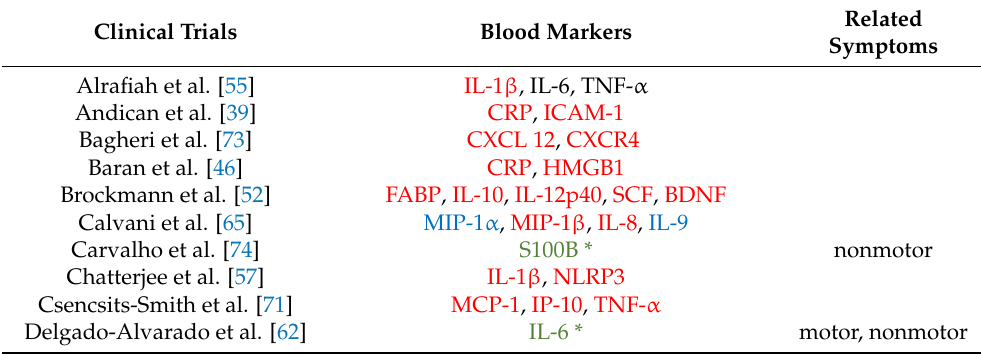
Table 1. Blood biomarkers and their related